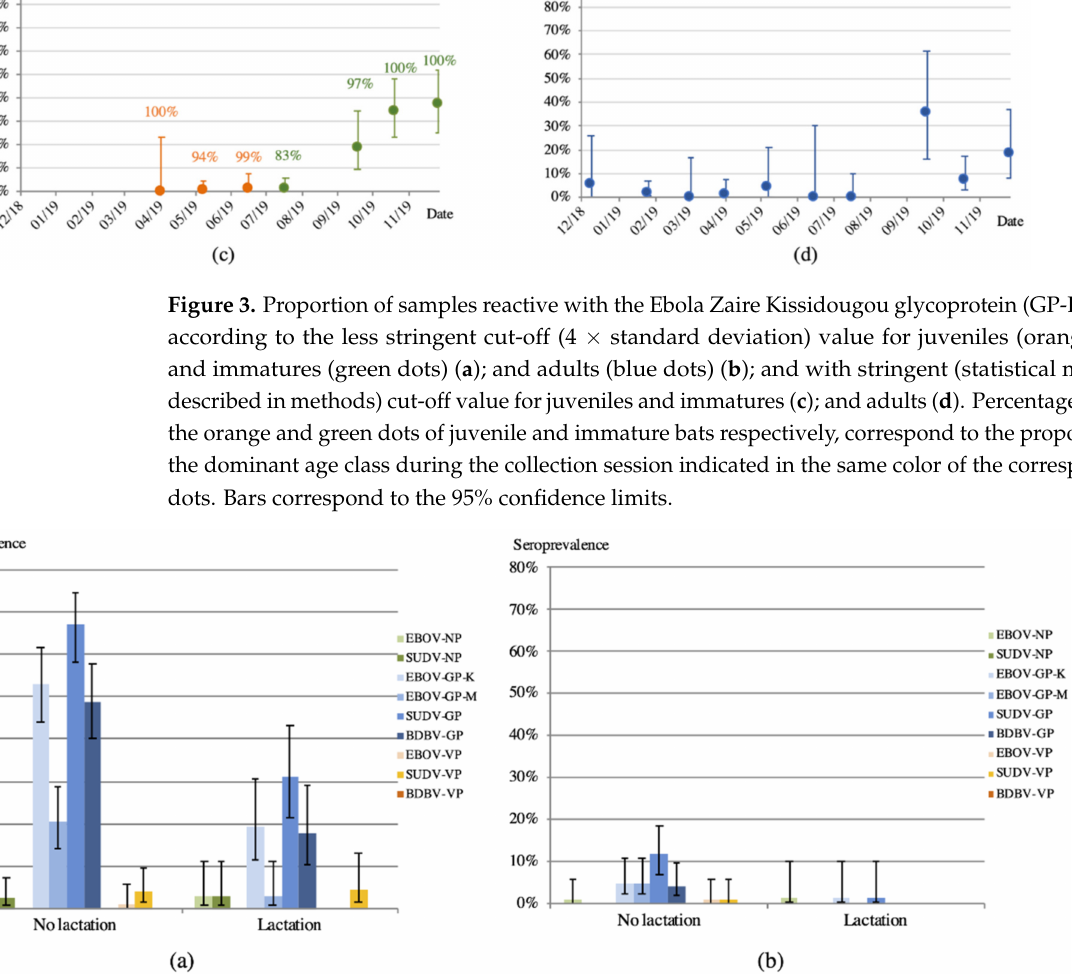
Figure 4. Percentage of adult female bats with antibodies to the different Ebolavirus antigens according to lactation status at capture with less stringent cut-off (4 × standard deviation) ( a ); and stringent cut-off (statistical methods described in methods) ( b ) calculations. Bars correspond to the 95% confidence limits, corresponding p values comparing the antibody reactivities for each antigen among lactating and non-lactating females are shown in Table